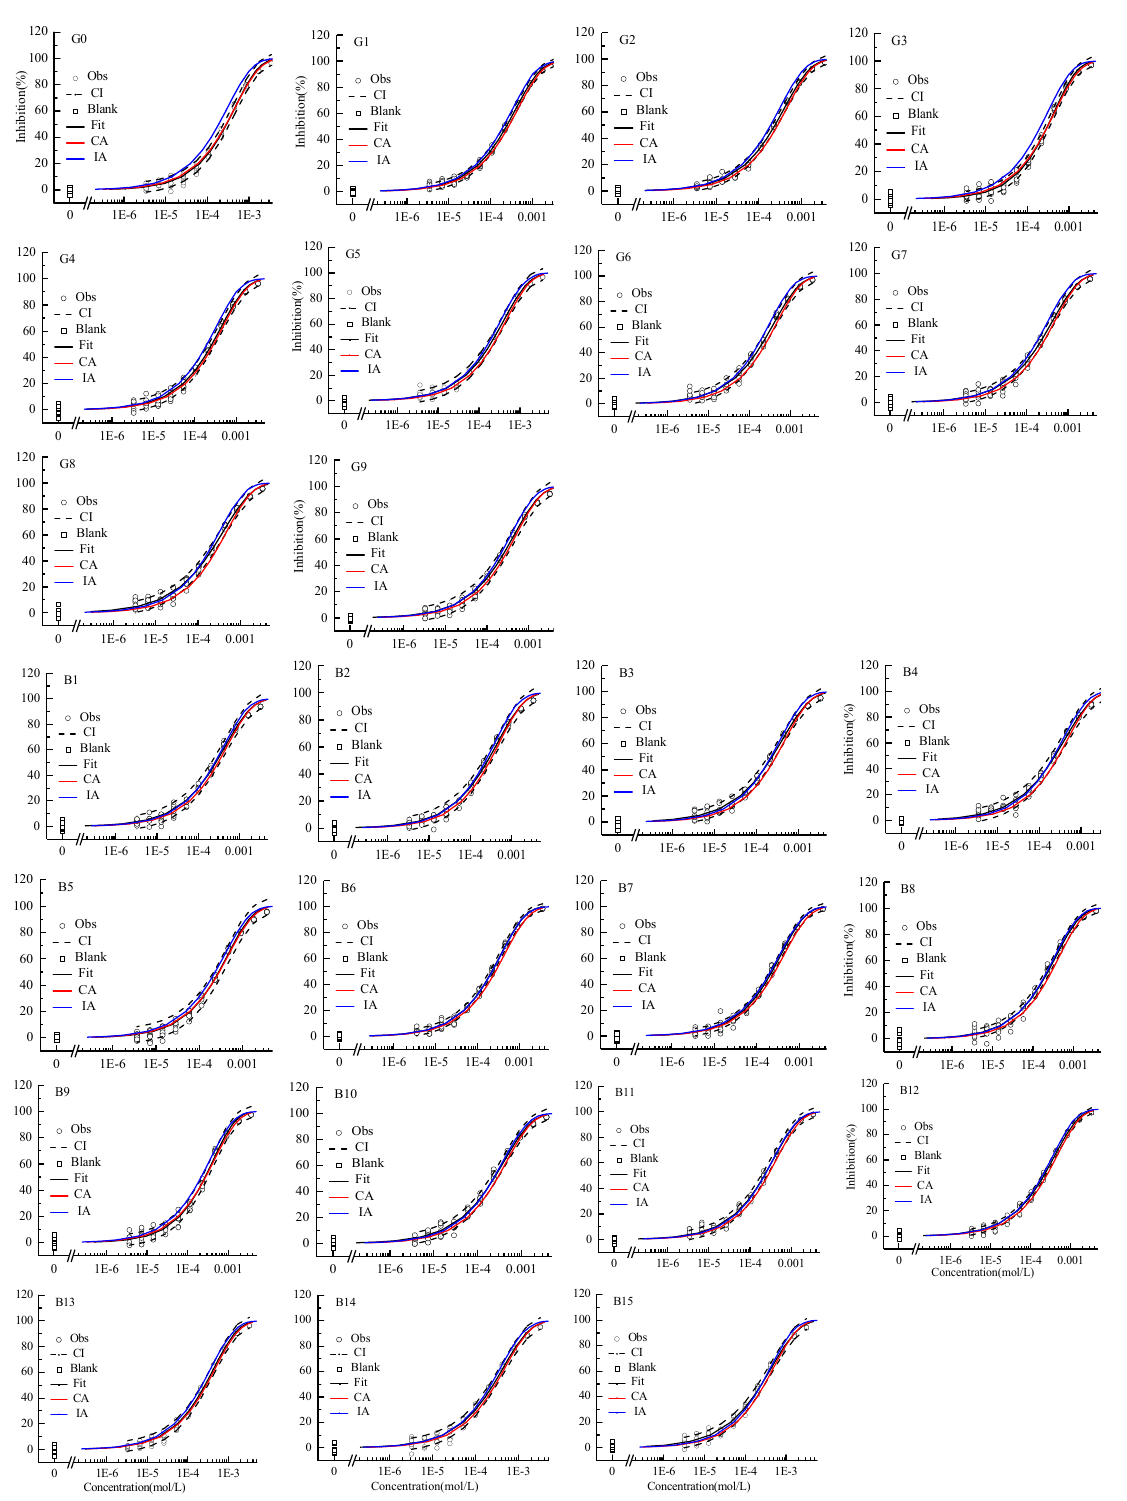
Figure 2. Concentration–response curves of ternary and binary mixtures of ILs inhibiting AChE. Note: Square: blank control; Circle: observed data; Black solid line: Weibull model fit; Red line: CA prediction; Blue line: IA prediction; Black dashed line: confidence interval